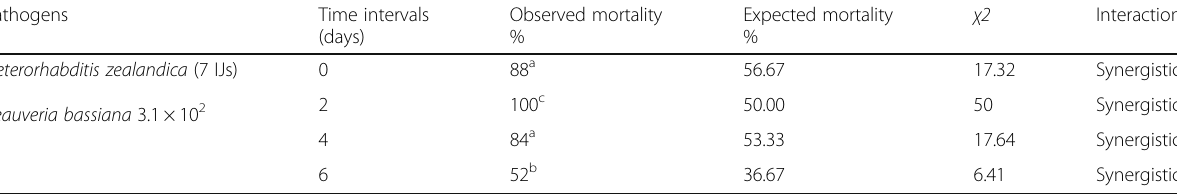
Table 2 Interactions observed after the combination of Heterorhabditis zealandica (7 IJs/larvae) with Beauveria bassiana (3.1 × 10 2 conidia/ml)